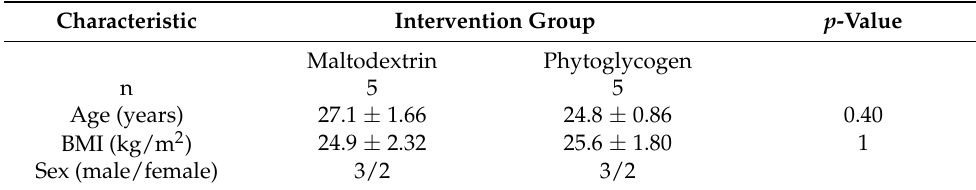
Table 1. Participant